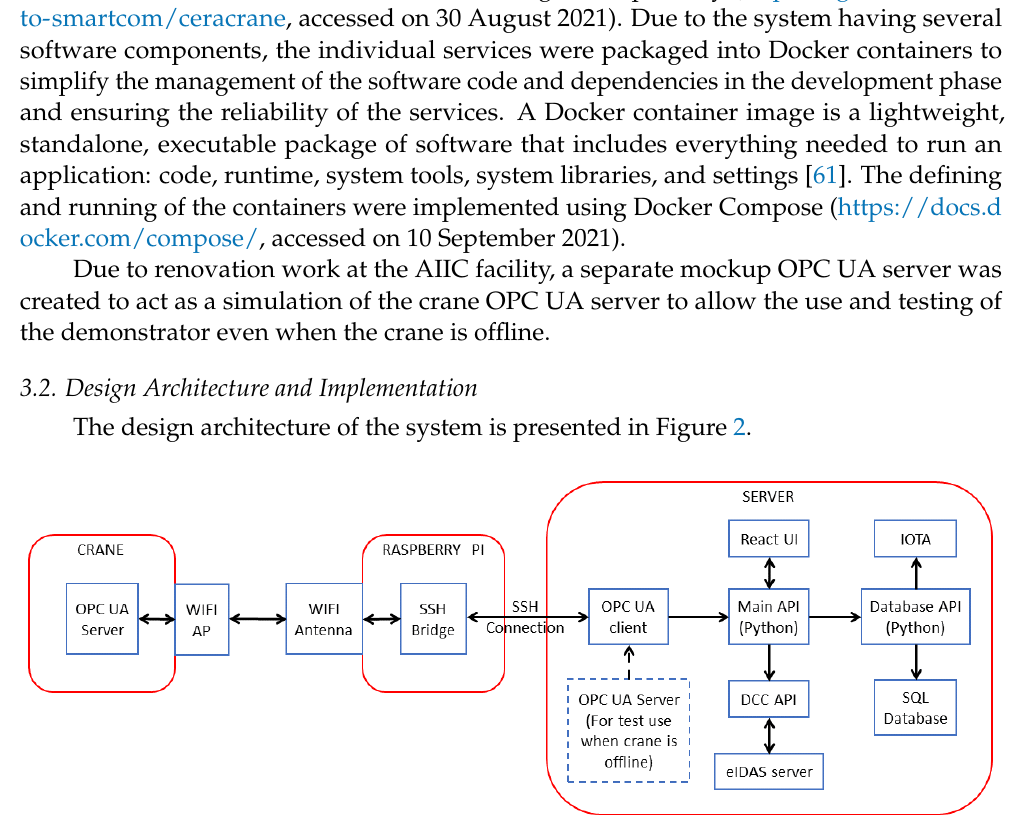
Figure 2. The design architecture of the demonstrator